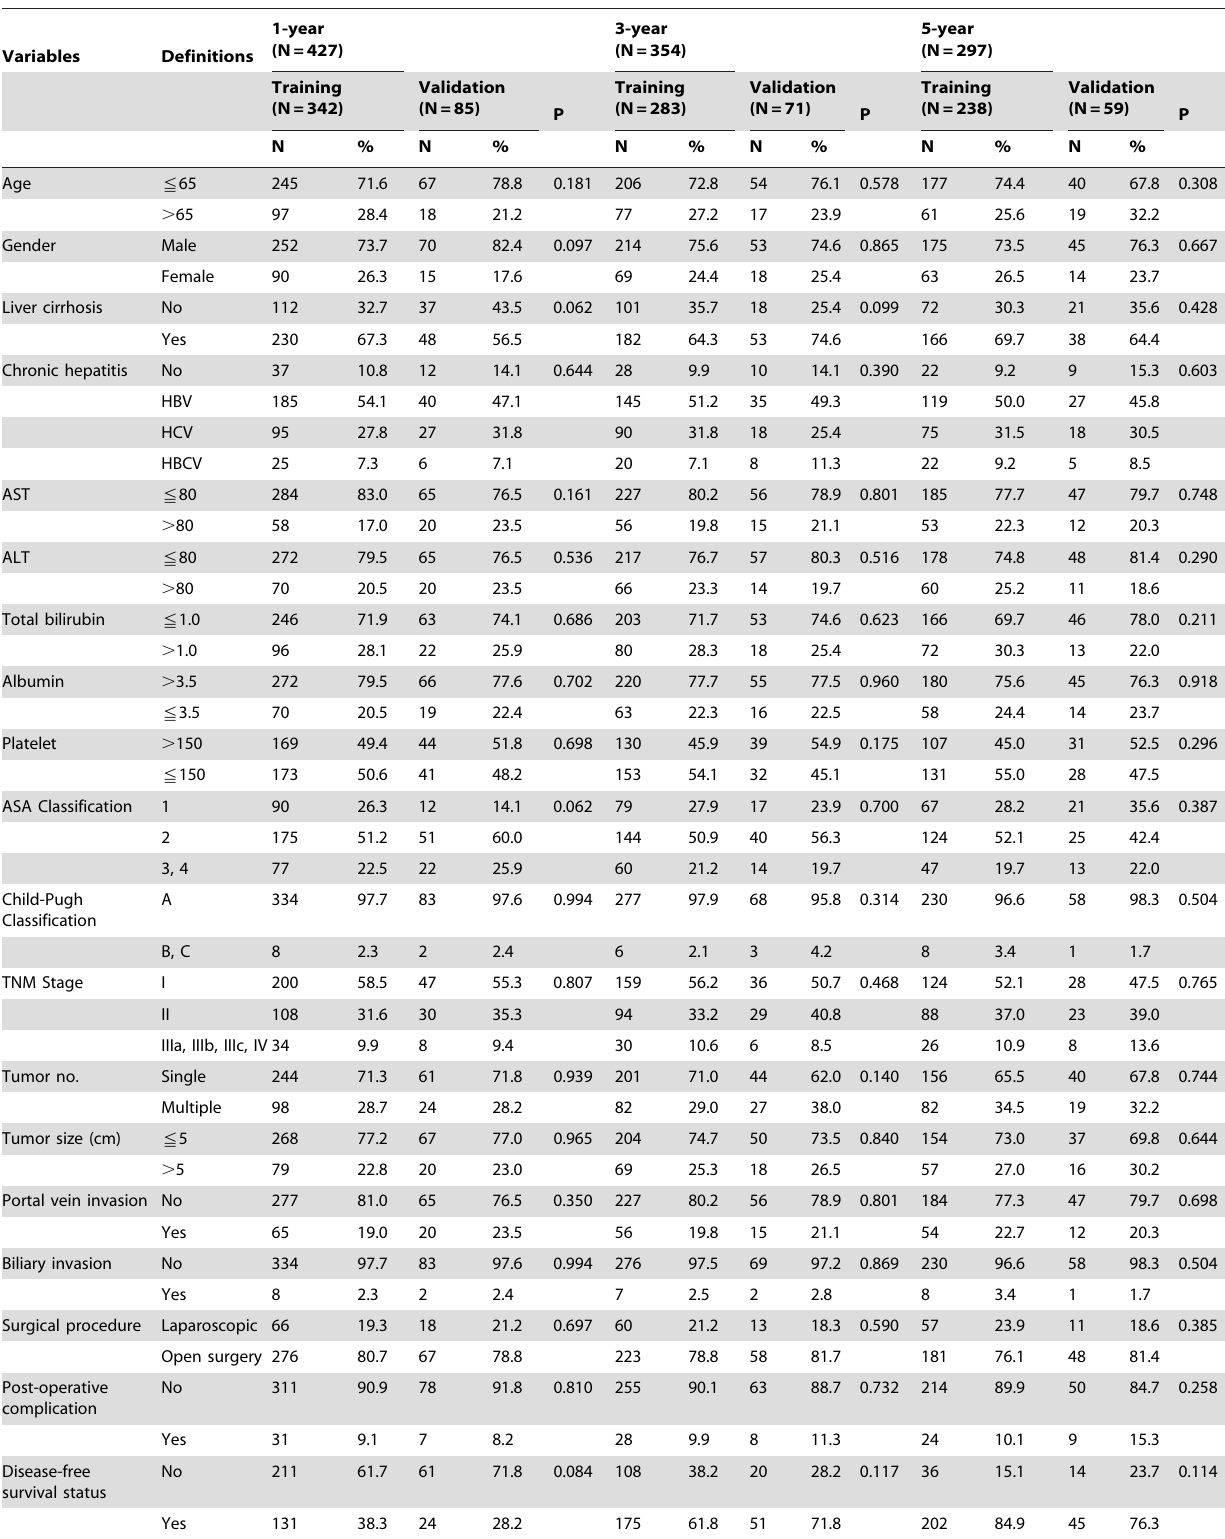
Table 2. Comparison of clinical features between training and validation